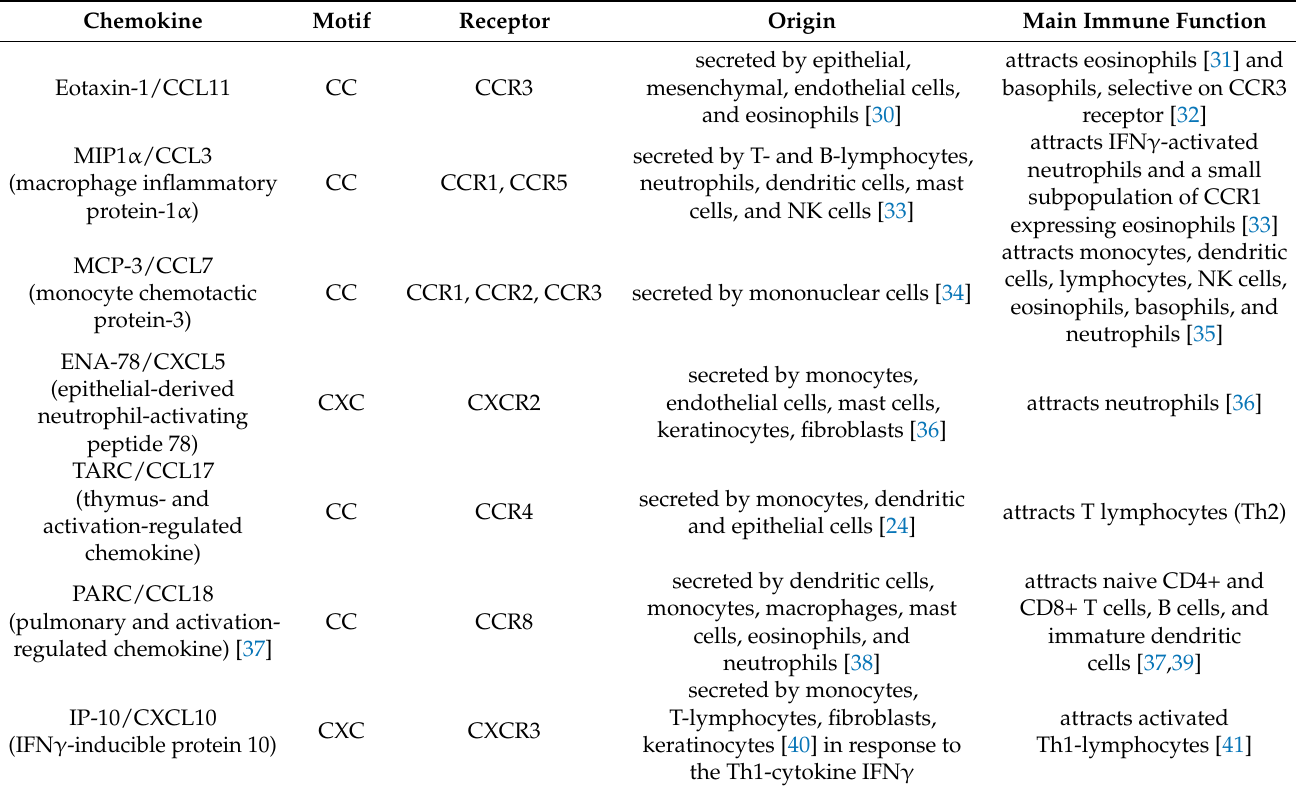
Table 1. Source and function of analyzed